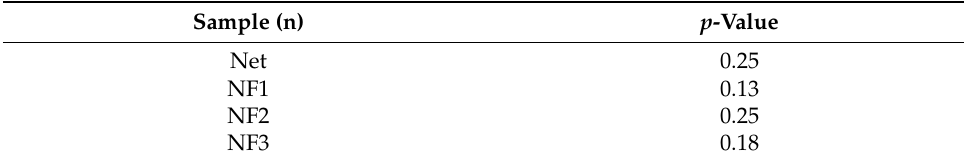
Figure 7. Mean values of the AC BDV along with error bars for the samples in question.